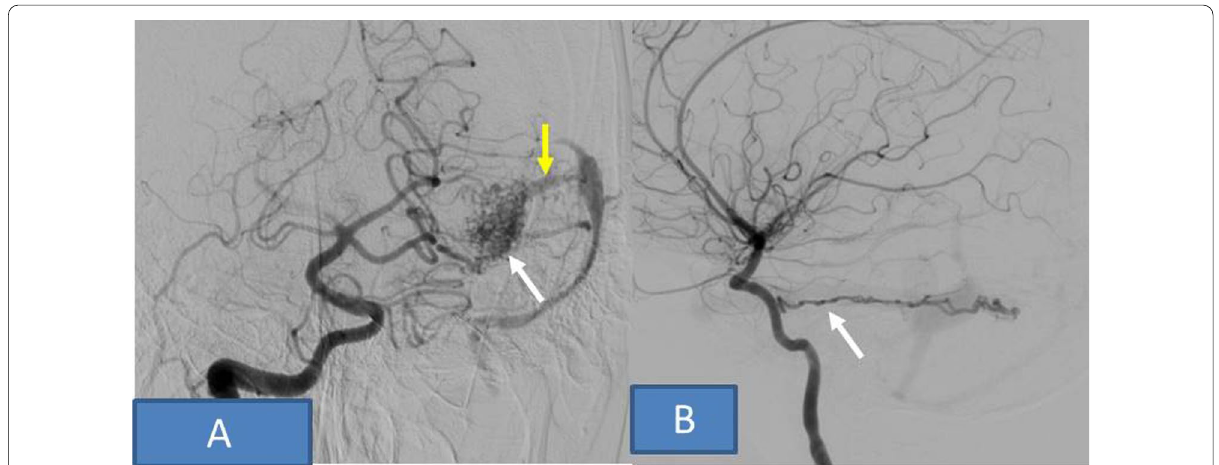
Fig. 3 Pial AVM; a DSA image in AP view showing pial AVM in the posterior fossa with arterial feeder from dilated SCA (white arrow) and drainage via early draining vein (yellow arrow) into the left transverse/sigmoid sinus, b DSA image in lateral view showing dilated meningohypopyseal trunk (white arrow) supplying the AVM